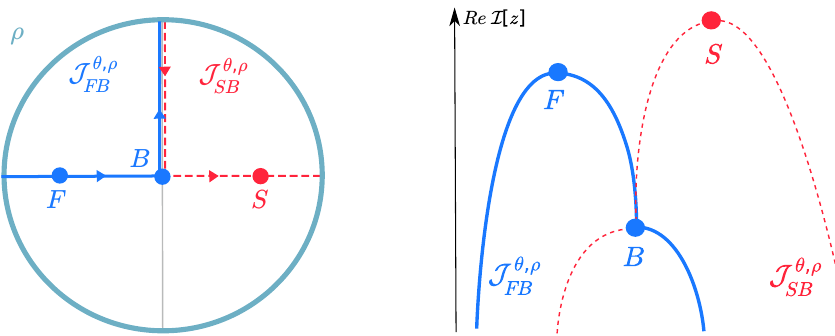
Figure 3 . Left: schematic representation of the special one-dimensional complex (cid:13)ows, associated with the negative mode for the bounce, that connect di(cid:11)erent saddles. The false vacuum, single bounce and shot saddle points are denoted by F; B; S denote, respectively; J (cid:18);(cid:26) (in blue) and J (cid:18);(cid:26) FB SB (in dashed red) are the one-dimensional (cid:13)ows that connect the false vacuum and the bounce, and the shot and the bounce, respectively. The circle represents in(cid:12)nity. The path integral acquires opposite imaginary parts from the vertical segments of the (cid:13)ows. Right: schematic illustration of the value of the function Re( I [ z ]) along the (cid:13)ows J (cid:18);(cid:26) and J (cid:18);(cid:26) , with the same notation and colour FB SB code as before. The (cid:13)ow J (cid:18);(cid:26) branches out at the bounce. Note that at each saddle point, there FB